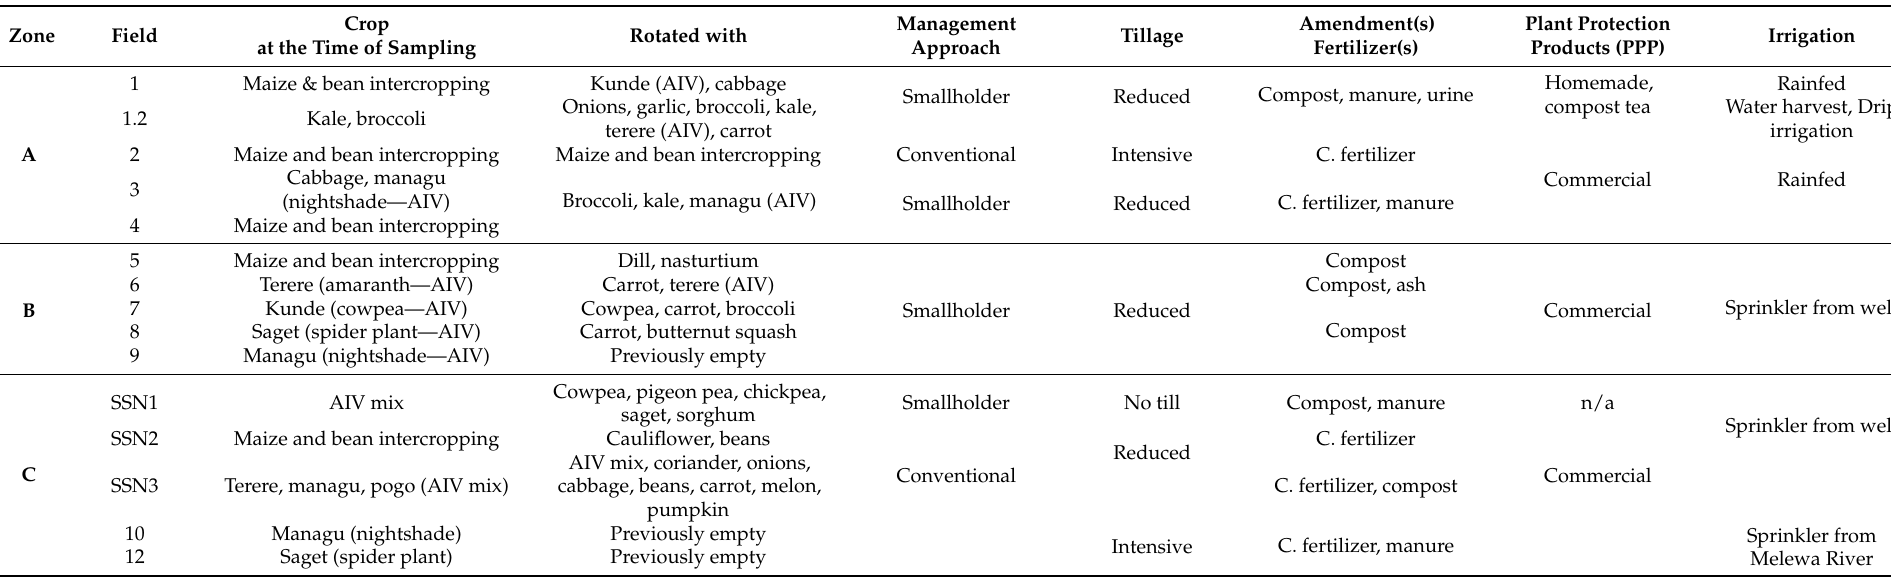
Table 1. General characteristics and management practices of surveyed fields (incl. = including, AIVs = African indigenous vegetables, C. fertilizer = Commercial fertilizer).